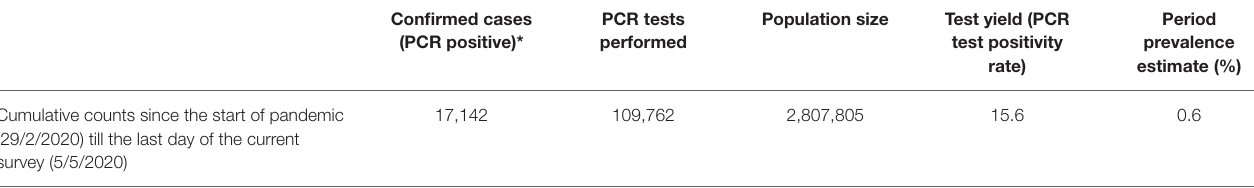
TABLE 3 | Estimated period prevalence rates of Qatar